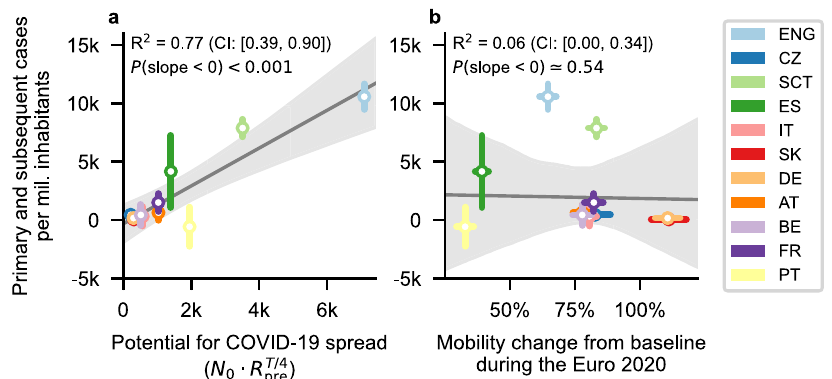
Fig. 3 | Which variables can predict the extent of the impact of Euro 2020 matches?a Thepotentialforspread,i.e.,thenumberofCOVID-19casesthatwould be expected during the time T a country is playing in the Euro 2020 ( N 0 (cid:1) R T = 4 pre ), is strongly correlated with the number of Euro 2020-related cases. Therefore, pol- icymakers should simultaneously consider the initial incidence N 0 , reproduction number prior to the event R pre , and expected duration of an event T to assess whether it is pertinent to allow it (The correlation is not signi fi cant if England and